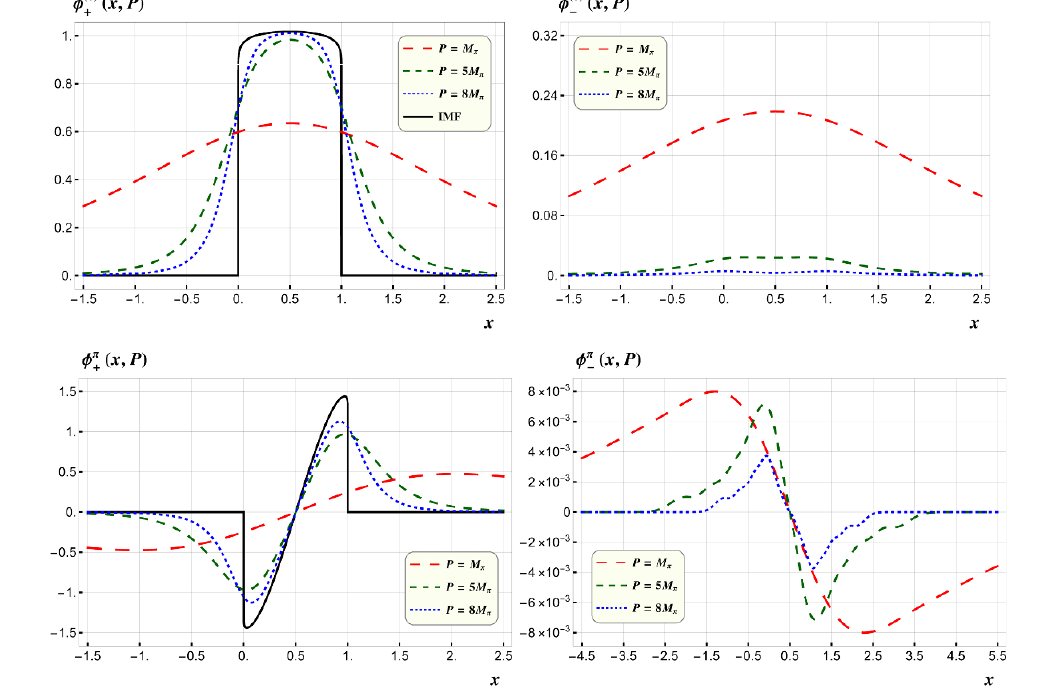
Figure 9 . Bars-Green wave functions for the low-lying u (cid:22) u states with m u = 0 : 045: physical pion ((cid:12)rst row), and the (cid:12)rst excited state (second row).